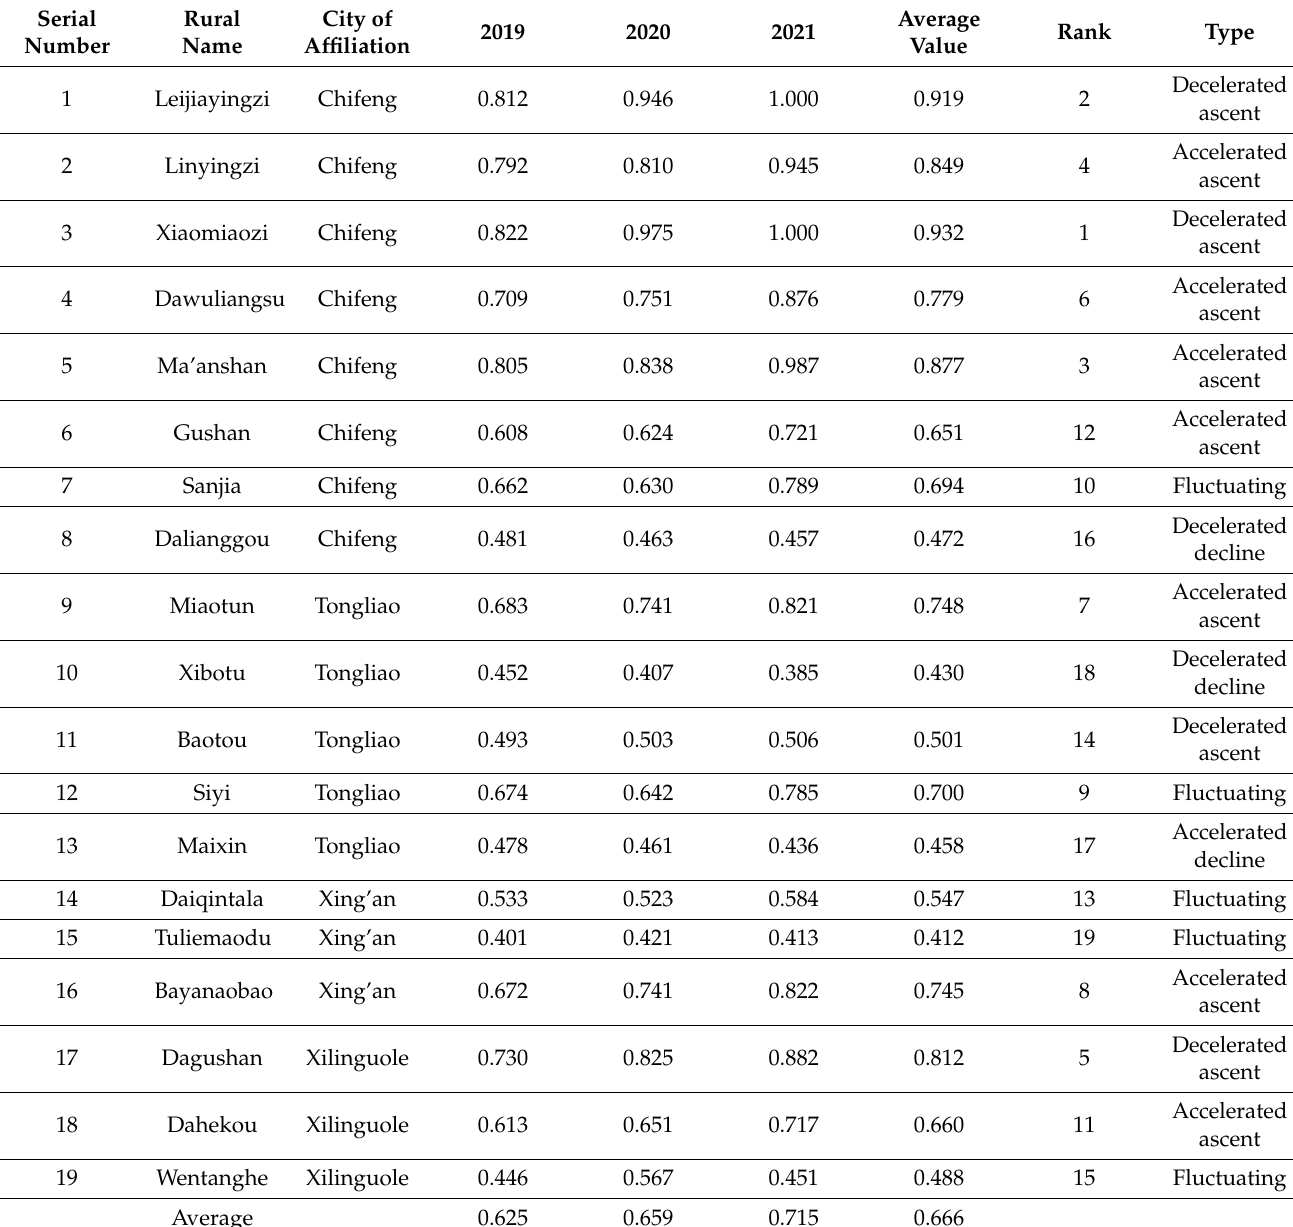
Table 3. Rank of the assessment of the preservation and inheritance value of rural areas in the Western Liao River Basin, Inner Mongolia,